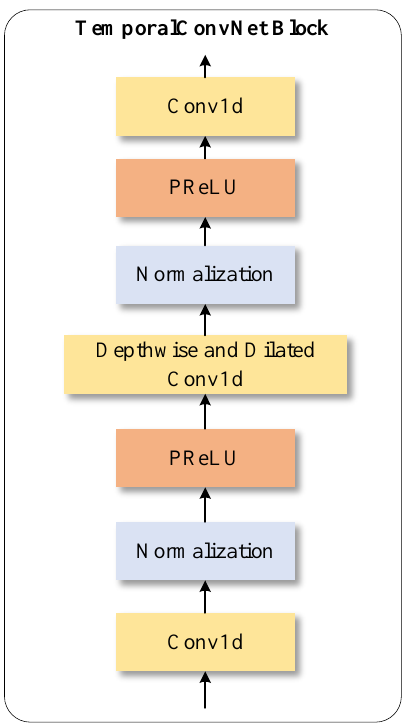
Figure 4. Structural design of the TCN module, which is designed for features extraction of intra- block speech.